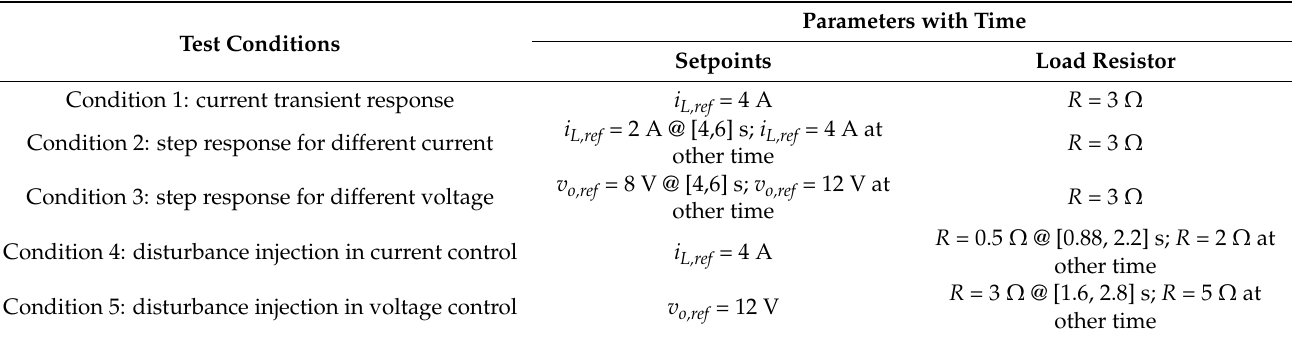
Table 2. Parameters of the test